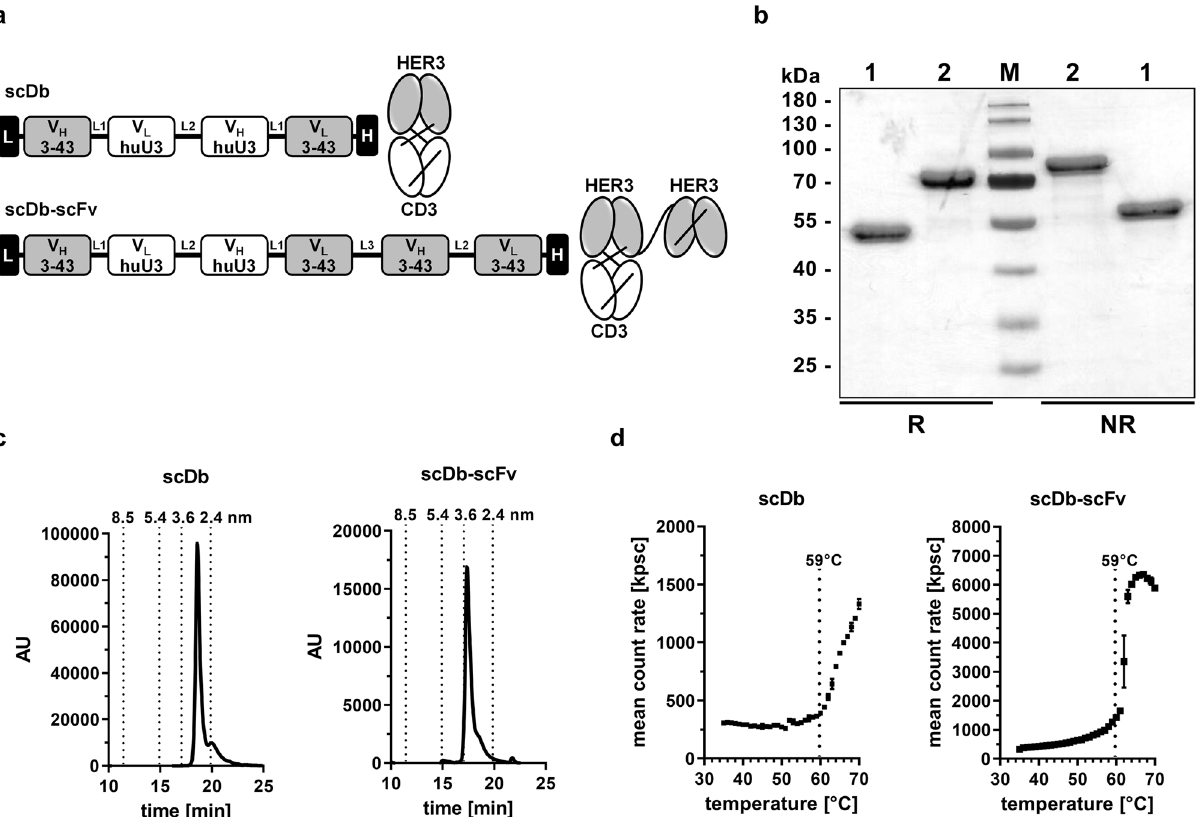
Figure 1. Biochemical characterization of scDb and scDb-scFv. ( a ) Composition and schematic illustration of scDb (1) and scDb-scFv (2). L, Igκ chain leader sequence. L1, G 4 S. L2, (G 4 S) 3 . L3, AAAGGS(G 4 S)GGGT, H, hexahistidyl-tag. ( b ) SDS PAGE analysis (12% PAA, 2 µg/lane, Coomassie blue staining) of (1) scDb and (2) scDb-scFv under reducing (R) and non-reducing (NR) condition. M, protein marker. ( c ) Size-exclusion chromatography by HPLC using a Tosoh TSKgel SuperSW mAb HR column. ( d ) Thermo stability determined by dynamic light scattering using the ZetaSizer Nano ZS (Malvern). Mean ± SD, n =